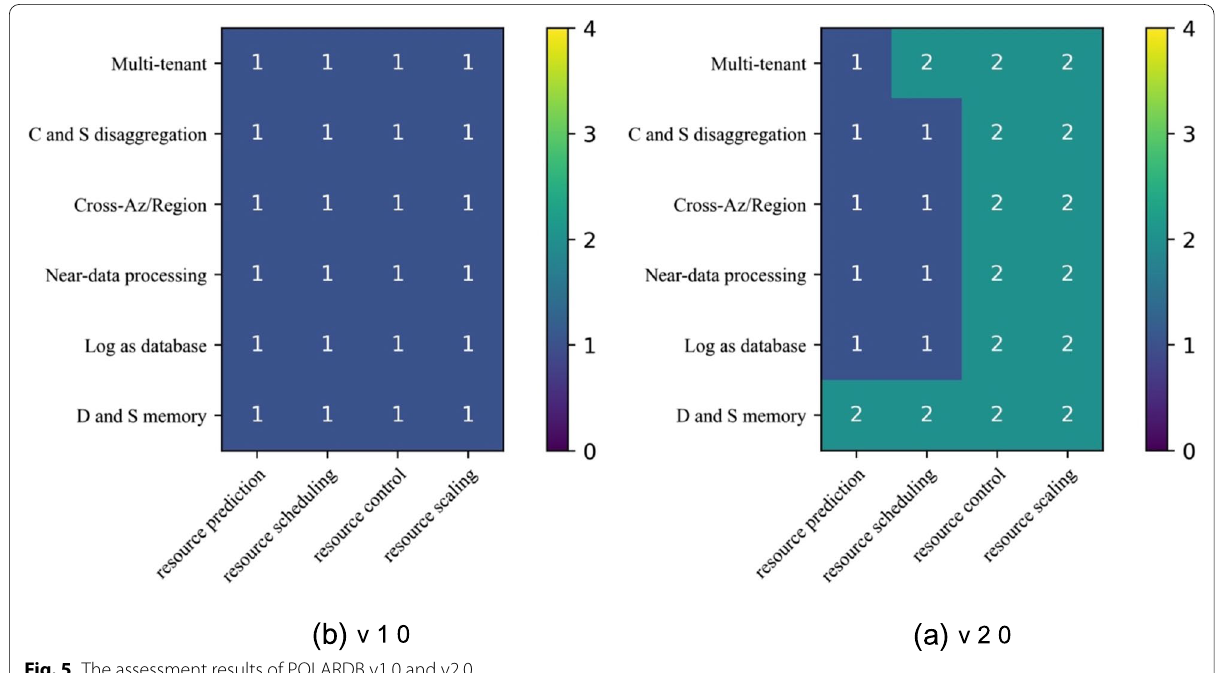
Fig. 5 The assessment results of POLARDB v1.0 and